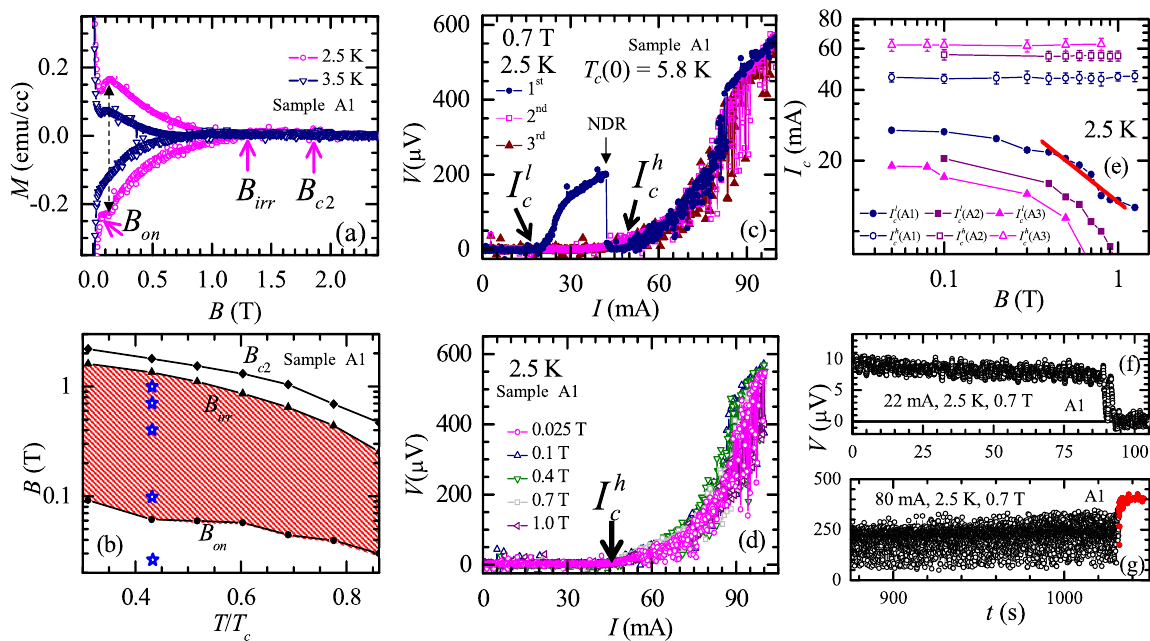
Figure 1. The bulk magnetization data, static vortex phase diagram and electric transport characteristics in 2H- NbS 2 . ( a ) Variation of bulk isothermal magnetization ( M ) response with magnetic field B ( B//c ) at 2.5 K and 3.5 K for sample A1. The magnetization hysteresis loop shows the second magnetization peak (SMP) anomaly. The vertical double arrow head line represents location of the maximum increase in Δ M at the peak of the SMP anomaly. The characteristics fields B on , B irr and B c 2 (see text for details) are marked with arrows. ( b ) B ( T/T c ) phase diagram for the static vortex state in sample A1 showing variation of B on , B irr and B c 2 with T/T c . The shaded region identifies a partially disordered vortex state whereas the region below B on represents ordered vortex state. The region between B irr and B c 2 represents a reversible vortex phase. The blue stars represent the B , T values at which we have measured the I-V characteristics in Fig. 1(d). ( c ) The I-V response at 2.5 K and 0.7 T for the 1 st (blue, filled circles), 2 nd (pink, empty square), and 3 rd (brown, triangle) runs (see text for details) in sample A1. The magnetic field of 0.7 T was reached by ramping the field at 0.03 T/minute. The I-V for the 1 st run shows an NDR transition at I ~ 40 mA and there after the vortex matter falls to a high I c state. The I cl and I ch are marked for the 1 st run. ( d ) I-V response measured at 2.5 K and different B (the locations of B are indicated by blue stars in Fig. 1(b)) for sample A1 showing depinning from the high I c state at I ch with large V -fluctuations. ( e ) Variations of I cl (closed symbols) and I ch (open symbols) with B at 2.5 K in log-log scale for sample A1 (circle), A2 (square) and A3 (triangle). The red solid line is a fit, ∝ α I B 1/ cl with α ~ 0.6 for sample A1. ( f ) Voltage as a function of time, V ( t ) data captured at 0.7 T, 2.5 K with I = 22 mA, showing transition to a high I c state after 90 s. ( g ) V ( t ) data (only last 150 s data) at 0.7 T, 2.5 K with I = 80 mA showing transition from a fluctuating (black points) to steady free flow (red points) response after 1025